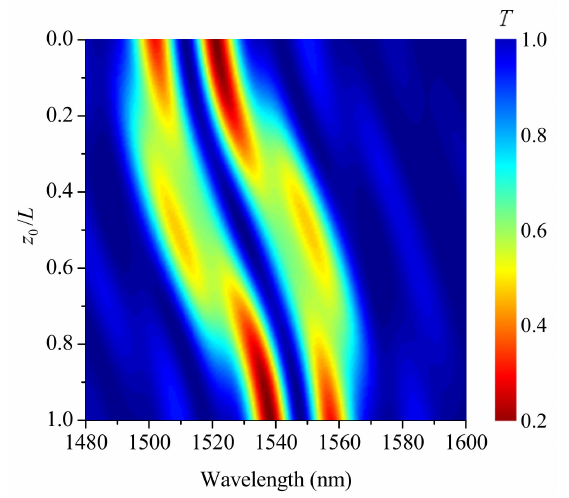
Figure 9. Evolution of transmission spectra with transition point z 0 moving through the π -shift LPFG for smoothness η = 10 mm (strain s 0 = 18).